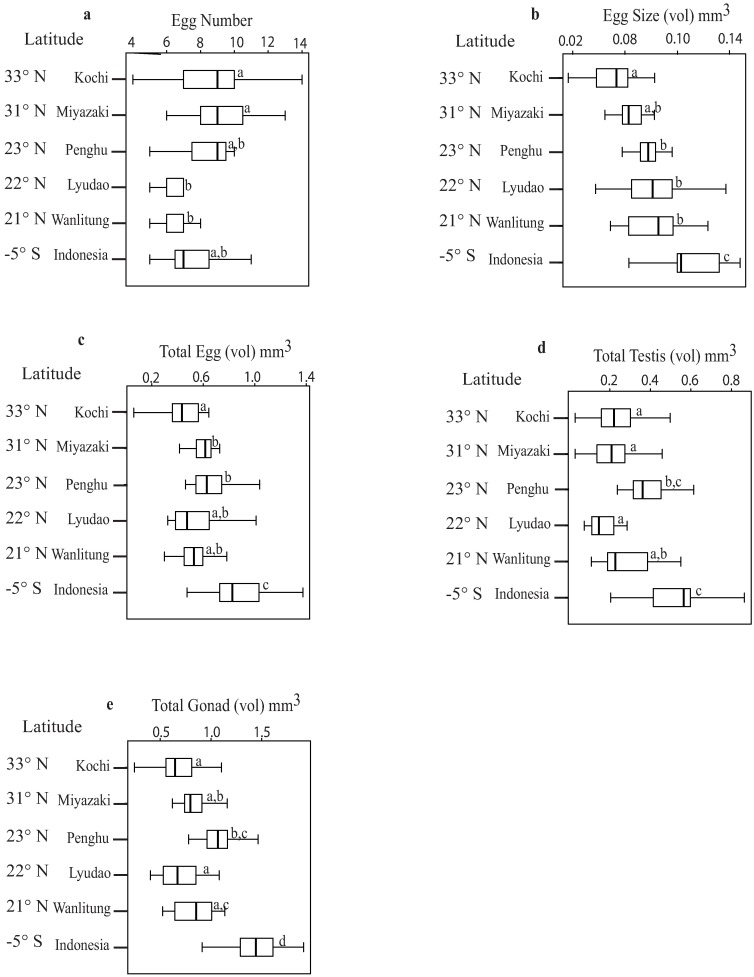
Regional variability in the reproductive traits in Acropora hyacinthus from the Western Pacific Region.Box plots represent latitudinal variations starting at the top with Kochi (33°N) and ending at the bottom with Indonesia (5°S). Box plots show all percentiles. The median (50th percentile) is highlighted with a thick bar. Different lowercase letters (a, b, c, d) indicate significant results of Tukey HSD tests among locations, with values at p < 0.001. Kochi and Lyudao include two years of data; other locations include one year of data.